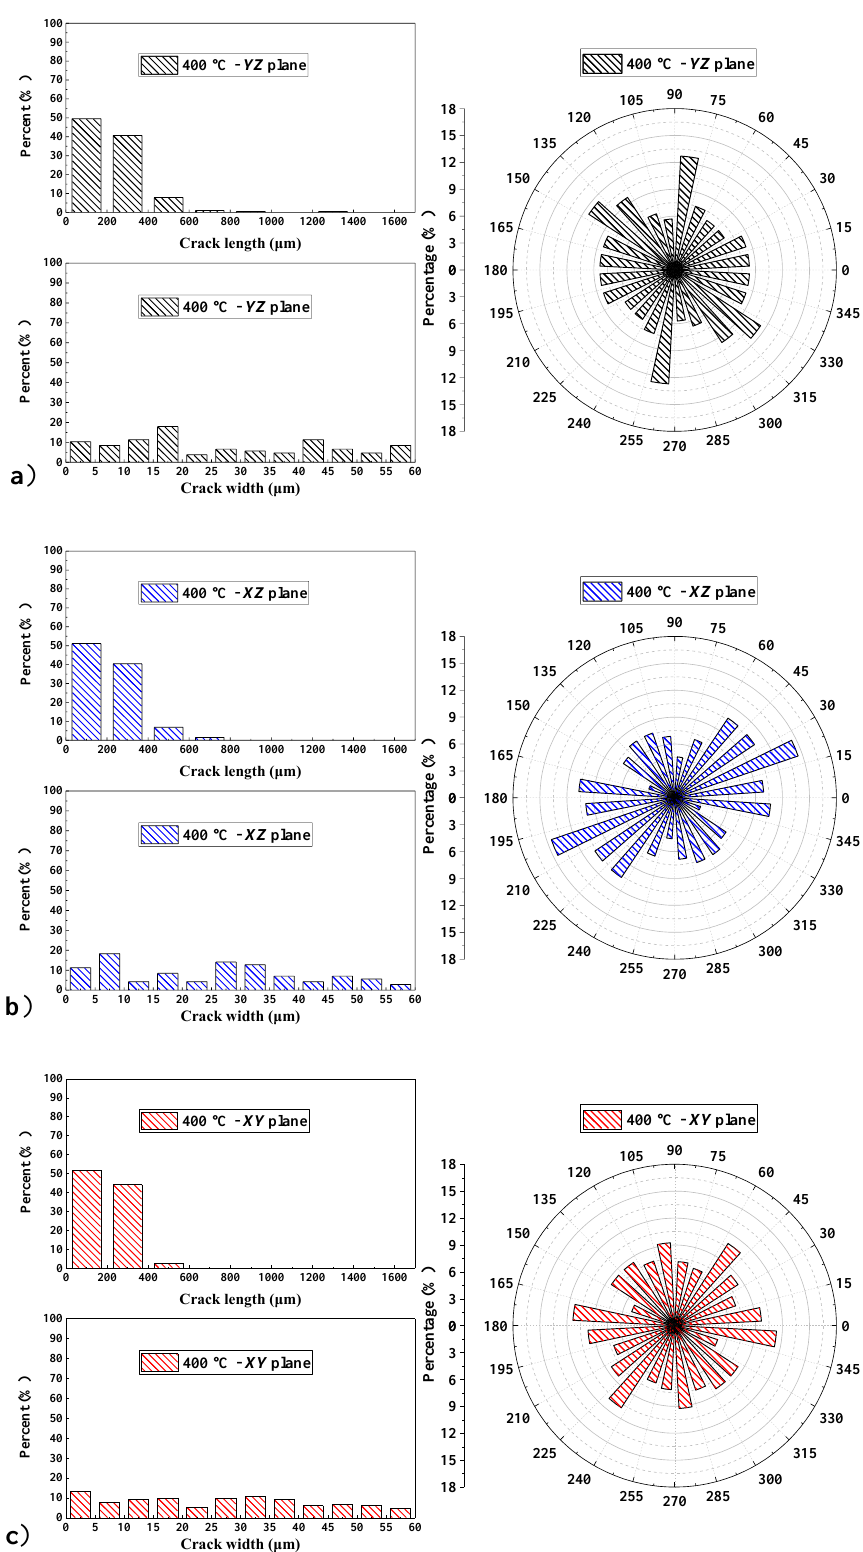
Figure 10. Characteristics of cracks for norite after 400 °C treatment, in ( a ) YZ plane; ( b ) XZ plane; and ( c ) XY plane.